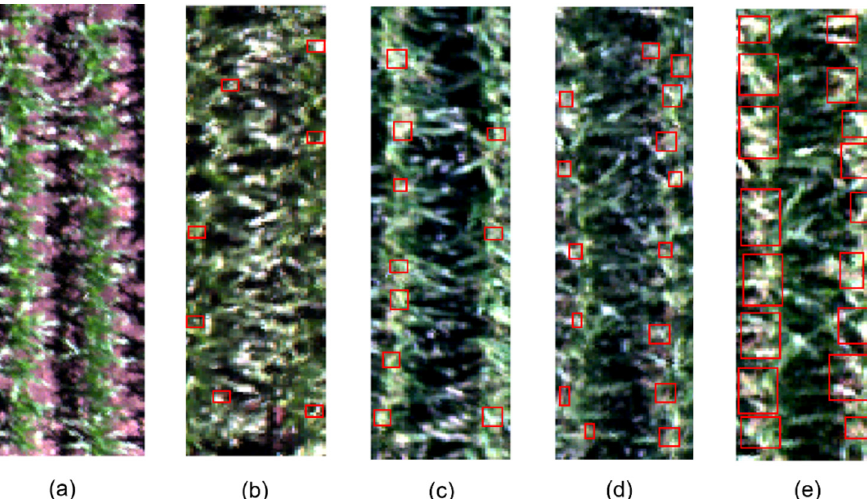
Figure 6. Canopy images of a maize plot at ( a ) the V6–V8 stage (41 DAS), ( b ) the VT stage (61 DAS), ( c ) the R1 stage (75 DAS), ( d ) the R3 stage (90 DAS), and ( e ) the R4 stage (103 DAS). The images were taken by the hyperspectral camera at a 42 m height and composited using the red (620 nm), green (530 nm), and blue (465 nm) bands from the hyperspectral imagery. Red boxes highlight the tassel parts on the maize canopy.